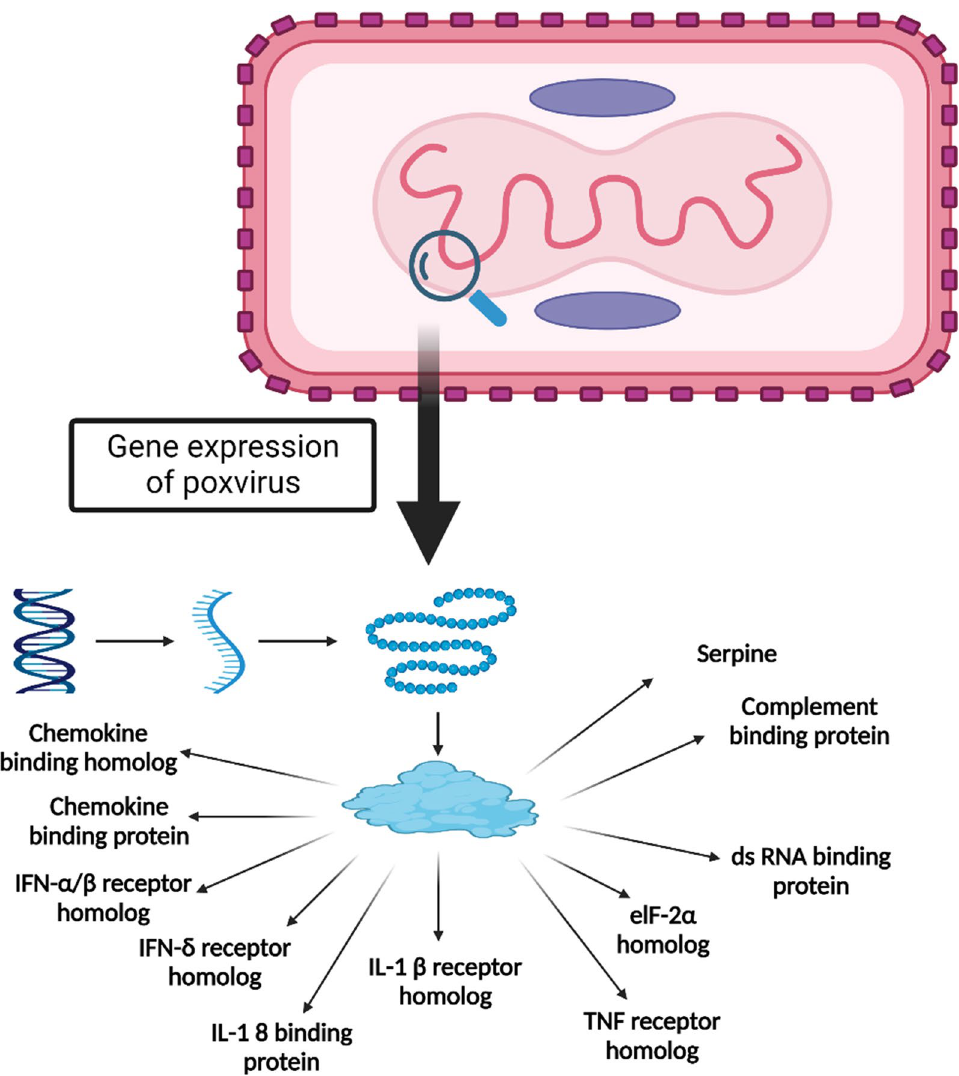
Fig. 2 Viroceptors and virokines of